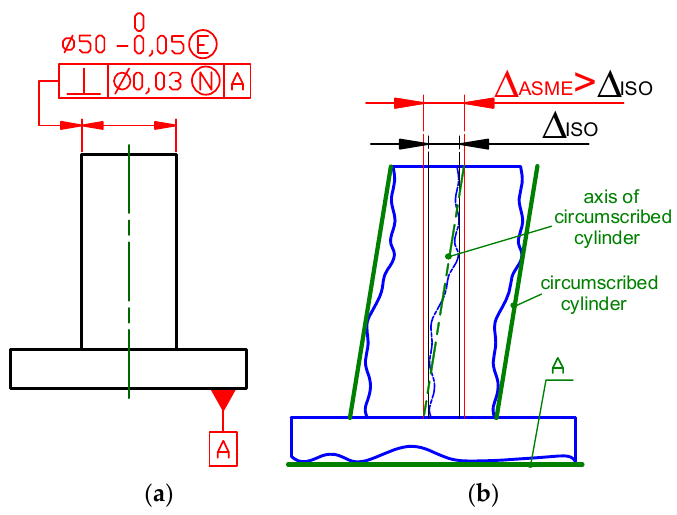
Figure 10. ( a ) Specification of perpendicularity tolerance for the pin with respect to the bottom of its flange (ISO GPS) equivalent to the specification given in Figure 9a; ( b ) perpendicularity deviation assessed according to ASME Y14.5 definition may be greater than that assessed according to the default ISO GPS, meaning that this controls the derived median line of the toleranced feature.